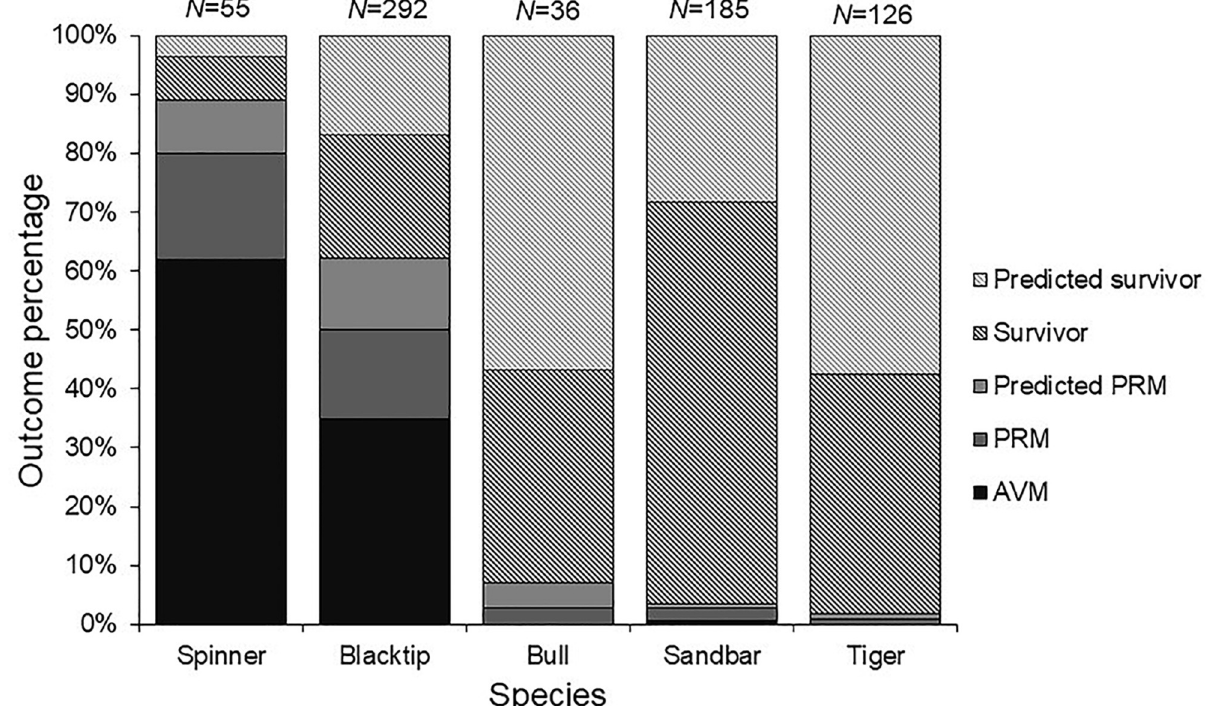
Fig 3. At-vessel and post-release fate percentages of the total catch by species. Individuals with the fate unknown (released alive but not tagged) were separated into either a predicted post-release mortality or predicted survivor by mirroring mortality rates for individuals with known outcomes. AVM = At-vessel mortality, PRM = post-release